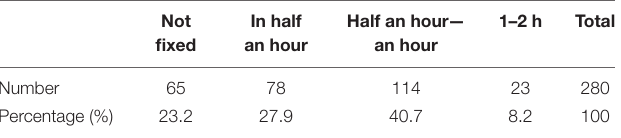
TABLE 3 | A survey of physical exercise duration of primary and middle school students in Tianjin.